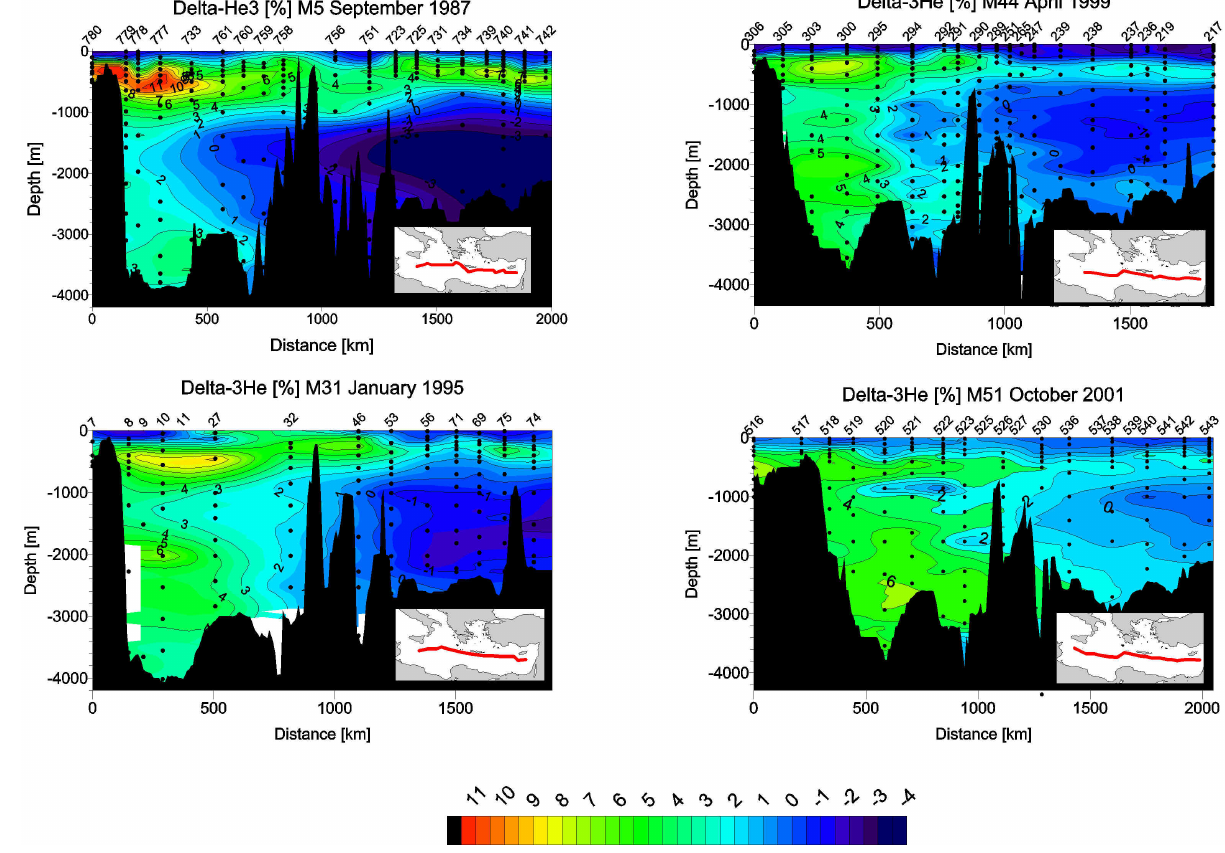
Fig. 7. Same as Fig. 2 but δ 3 He sections (%). Note that in 1987 the deep waters in the Levantine Sea were largely below the solubility equilibrium value.